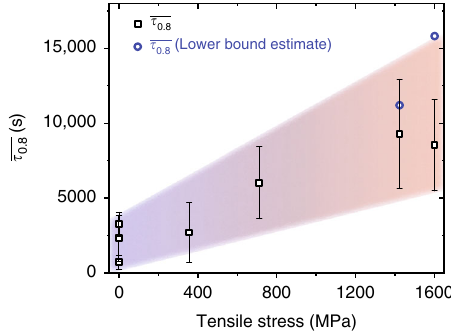
Fig. 6 Stress dependence of the average momentary relaxation time. The average momentary relaxation time increases with applied tensile stress. Square symbols show standard deviations. Round symbols are lower-bound estimates based on the measurement duration of the corresponding τ . The aggregated data points strongly suggest on-average 0 : 8 slower dynamics with increasing tensile stress from 0 to 0.94 σ y . It should be noted that a regime of stationary dynamics (constant τ at any stress) may be emerging at the long-time limit, which 0 : 8 would mean that all stress-biased thermally activated dynamics has been exhausted. Veri fi cation of this long-time limit is, however, outside any experimental feasibility.